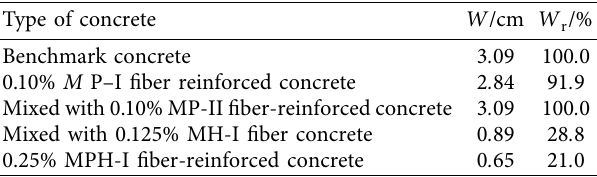
Table 5: Efects of engineering fbers on drying shrinkage cracking in the early stage of